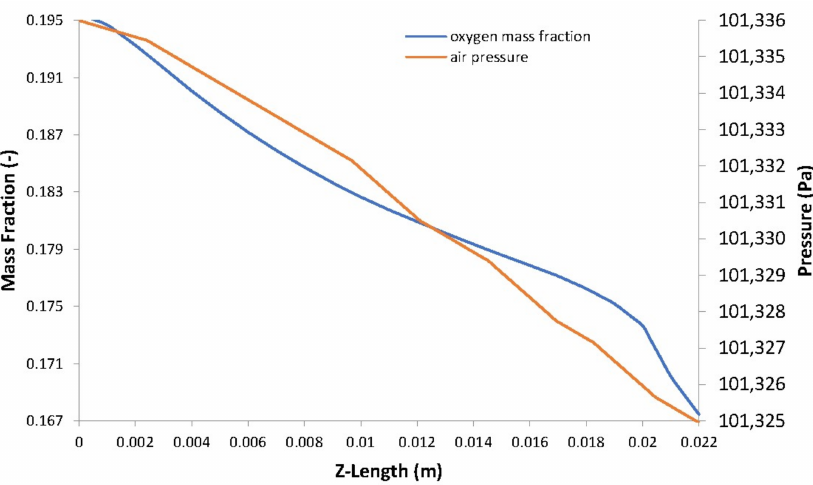
Figure 12. Oxygen mass fraction vs. air pressure.